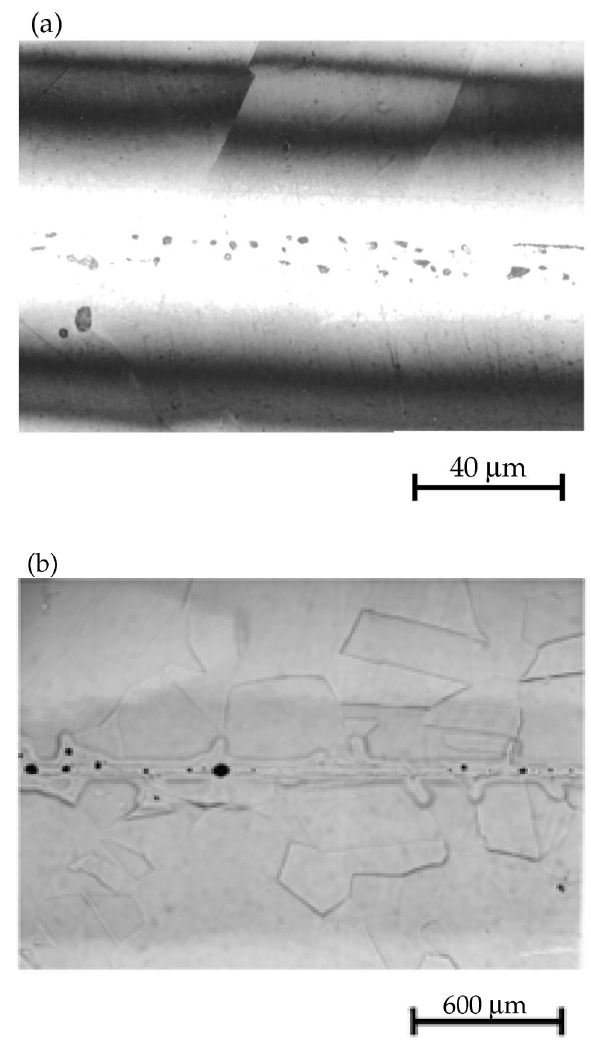
FIG. 8. Microstructures of the PVD deposited 1 m m - Ni (cid:1) 3 m m - Au vacuum furnace brazes. (a) This braze was heated to 1000 ± C, contains porosity, and did not clearly show evidence of melting. (b) This braze was heated to 1060 ± C to ensure melting but produced a very wide joint and contains porosity as